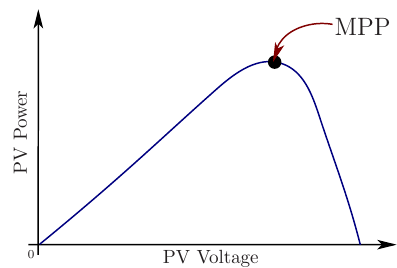
Figure 1. Representation of a possible maximum power point under invariant irradiance and temperature conditions of a photovoltaic (PV)